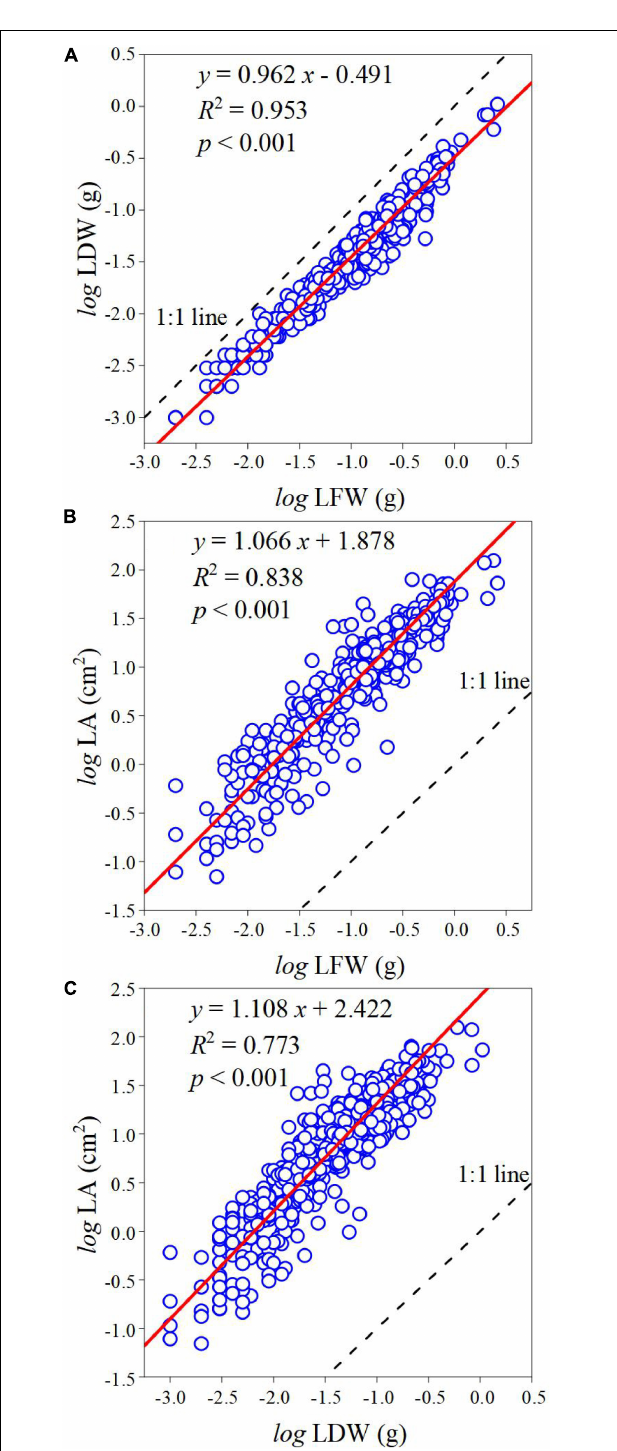
FIGURE 3 | The scaling relationship between leaf traits. (A) The scaling relationship between LFW and LDW. (B) The scaling relationship between LFW and LA. (C) The scaling relationship between LDW and LA. The blue circle represents observed values, the red line represents the SMA regression line, and the black-dotted line represents the 1:1 line; R 2 is the coefficient of determination that is used to measure the goodness of fit; p represents the significant level of goodness of fit at 0.05